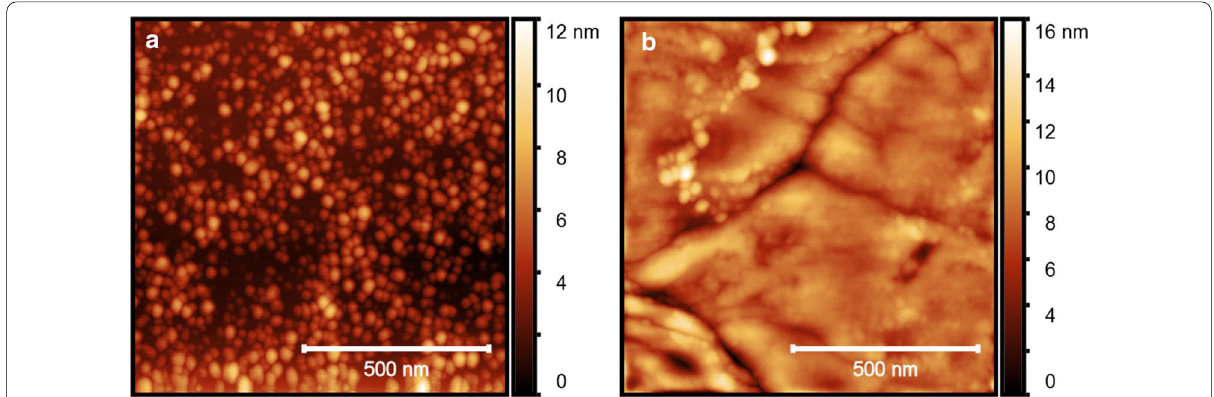
Fig. 2 AFM images of ZnO NP seed layers prepared on top of a Si wafer by a sol-gel method after a one- and b two-step dip-coatings, respectively, followed by an annealing step at 300 °C after each coating. A polynomial background has been subtracted from the AFM